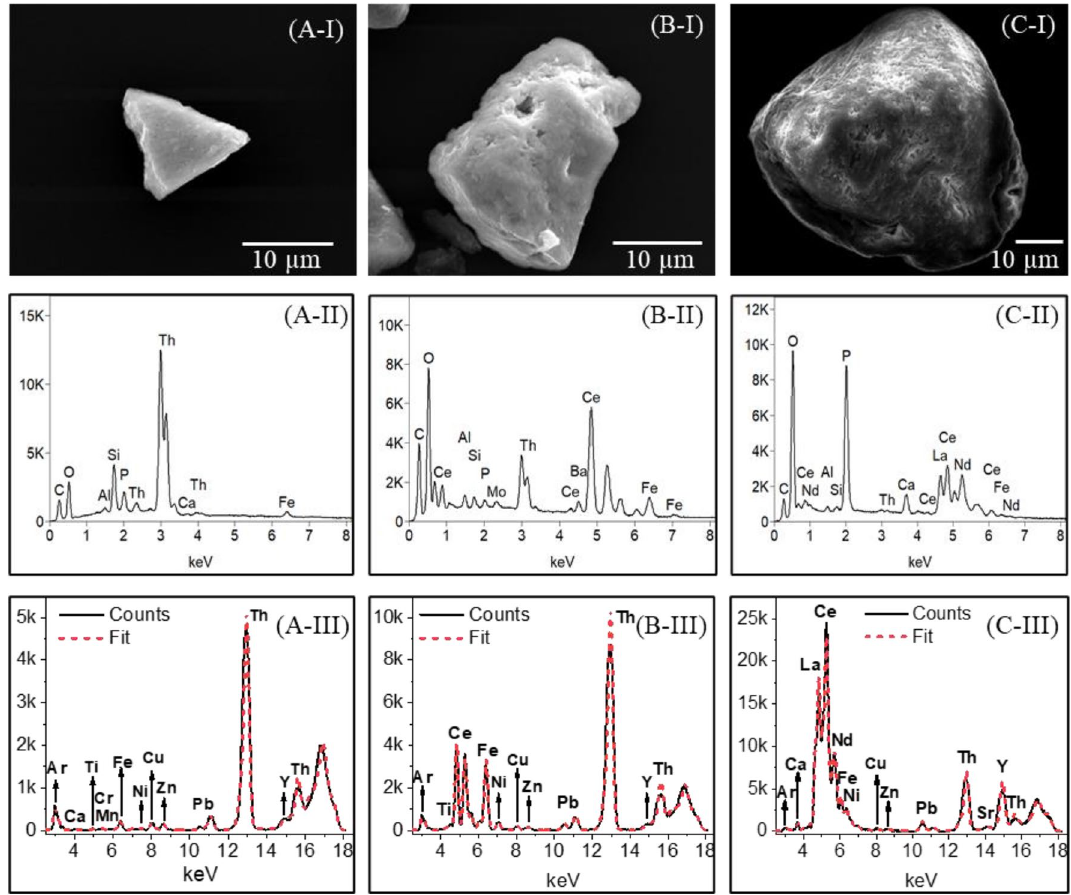
Figure 2. The SEM images (I), corresponding EDX (II), and µ-XRF spectra with fits (III) of selected ( A ) Th-silicate, ( B ) Th-Ce-oxide, and ( C ) Th-REE-phosphate rich particles, respectively.